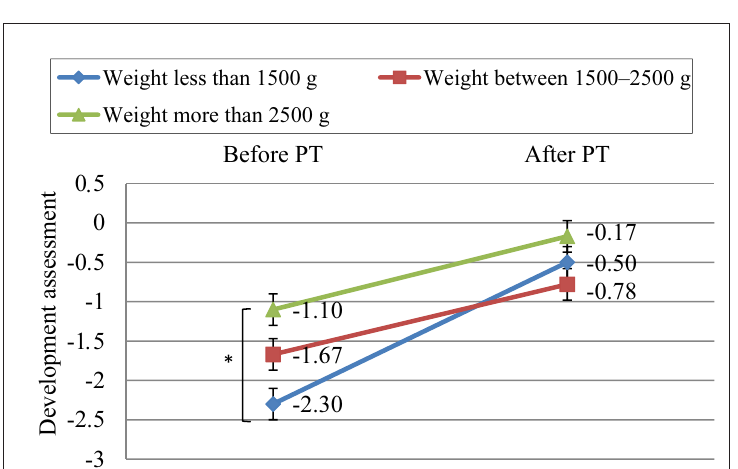
groupsNote. Figure 2. Sitting development evaluation in different birth weight infant groups Figure 3. Walking development evaluation in different birth weight infant groups